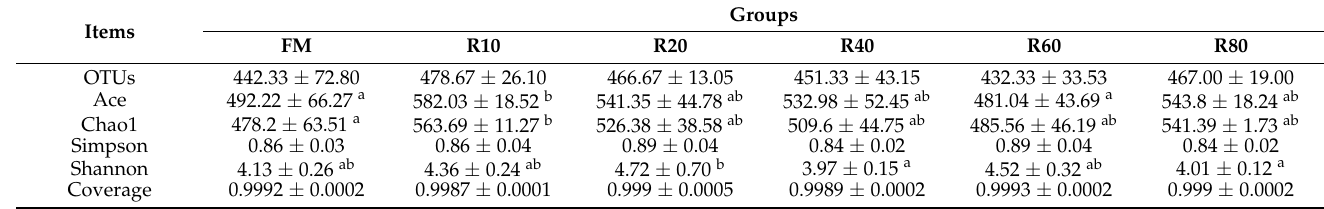
Figure 2. Effects of RPM replacing fishmeal on hepatopancreatic non-specific immune relative mRNA expression for juvenile shrimp L. vannamei . Data are expressed as means ± SD ( n = 3). Different letters above a bar were statistically significant different among treatments ( p < 0.05). Table 9. Effects of RPM replacing fishmeal on intestinal species diversity for L. vannamei .